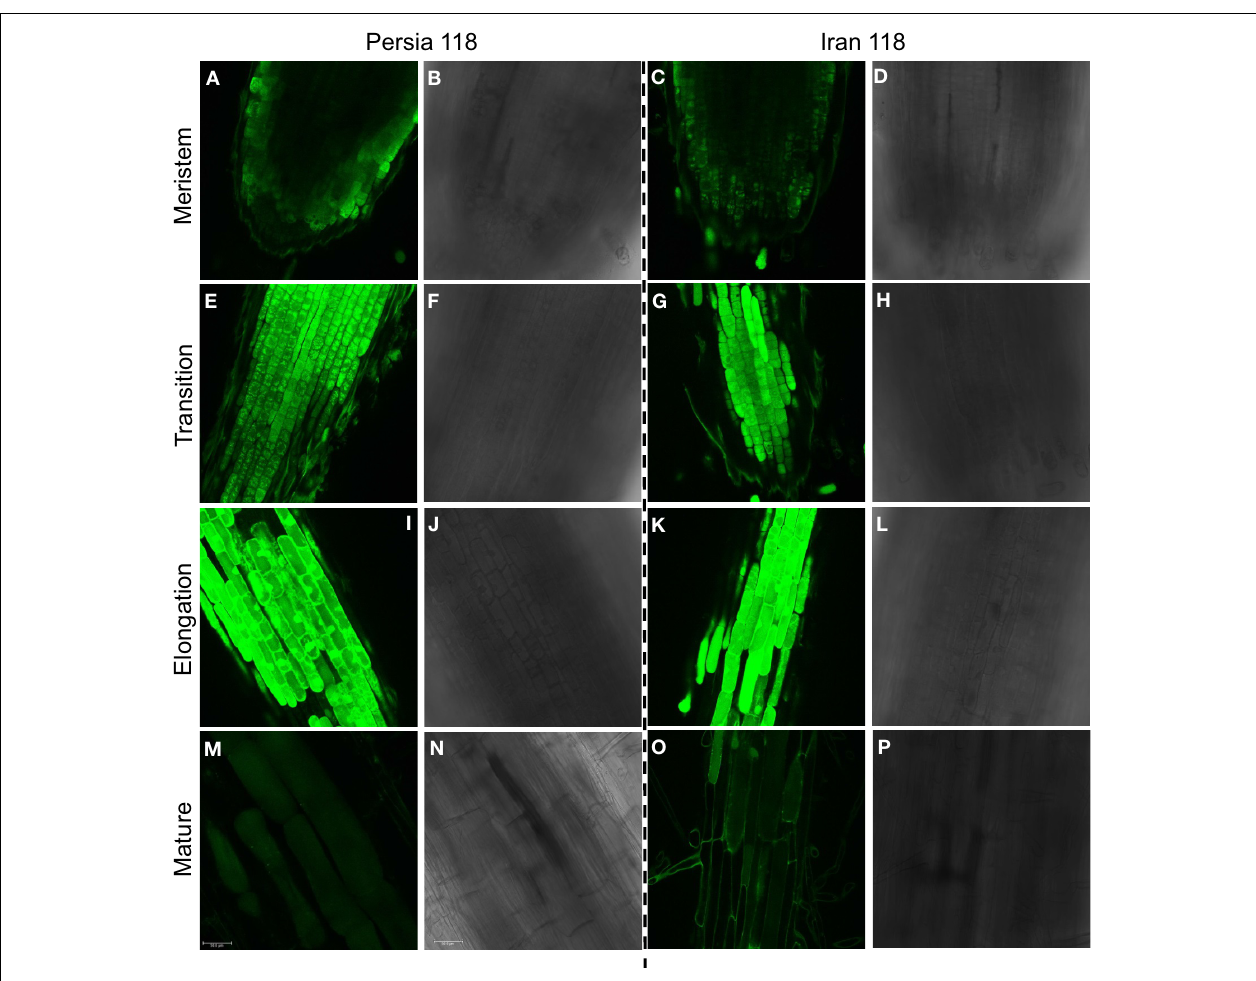
FIGURE 6 | Na + accumulation profiles in bread wheat visualized by CoroNa Green dye imaging. The representative images of Na + distribution within one tolerant (Persia 118) and one sensitive (Iran 118) varieties are shown for four different root zones: meristem